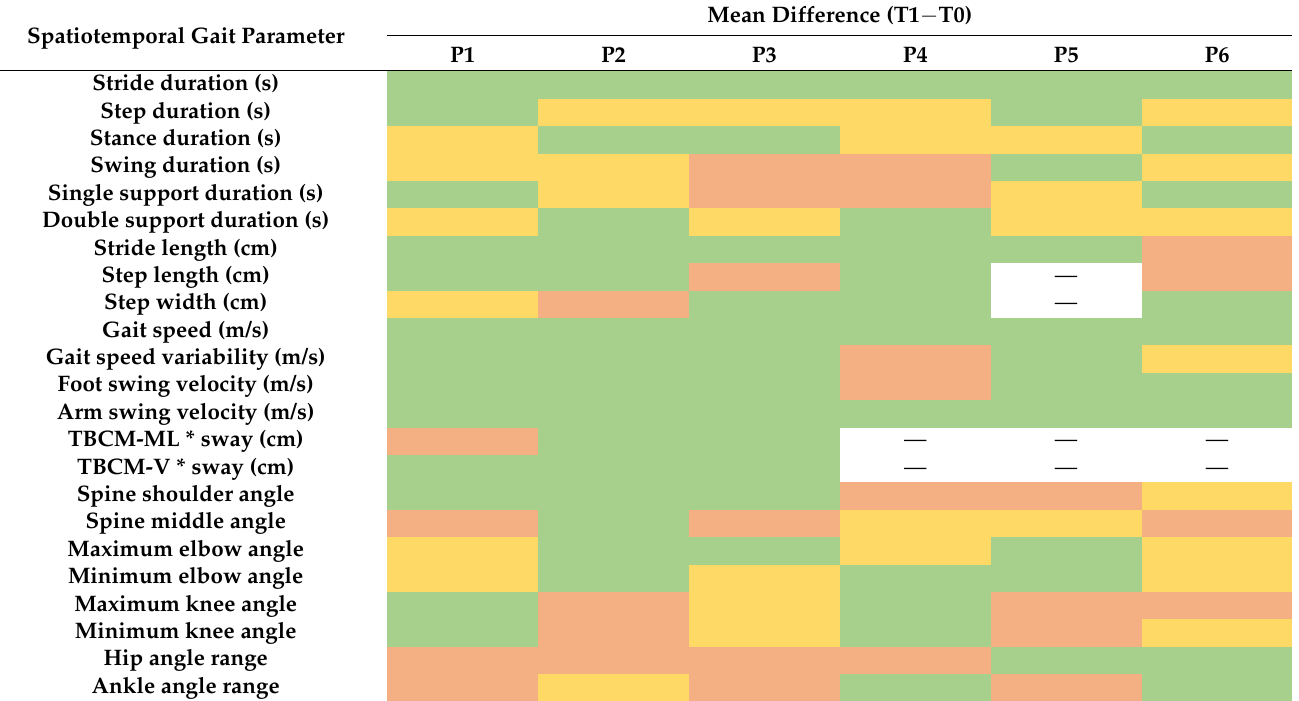
Table 3: stride duration, gait speed, arm swing velocity, stride length, foot swing velocity, and gait speed variability. Table 4 provides a representation of Table 3’s results. Table 4. Representation of the difference between the two used systems for each parameter and patient. When both systems have the same result it is shown in green, it is shown in yellow when they have the same tendency but one does not show a statistically significant difference, and in orange when the tendency and the difference are not the same. “—” indicates that it was not possible to perform the statistical test due to the small amount of available